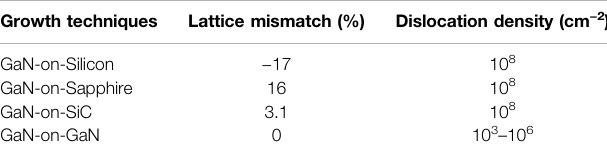
TABLE 1 | The comparison of dislocation density of different growth techniques. The lattice mismatch is calculated by ( a epi − a sub )/ a sub. Growth